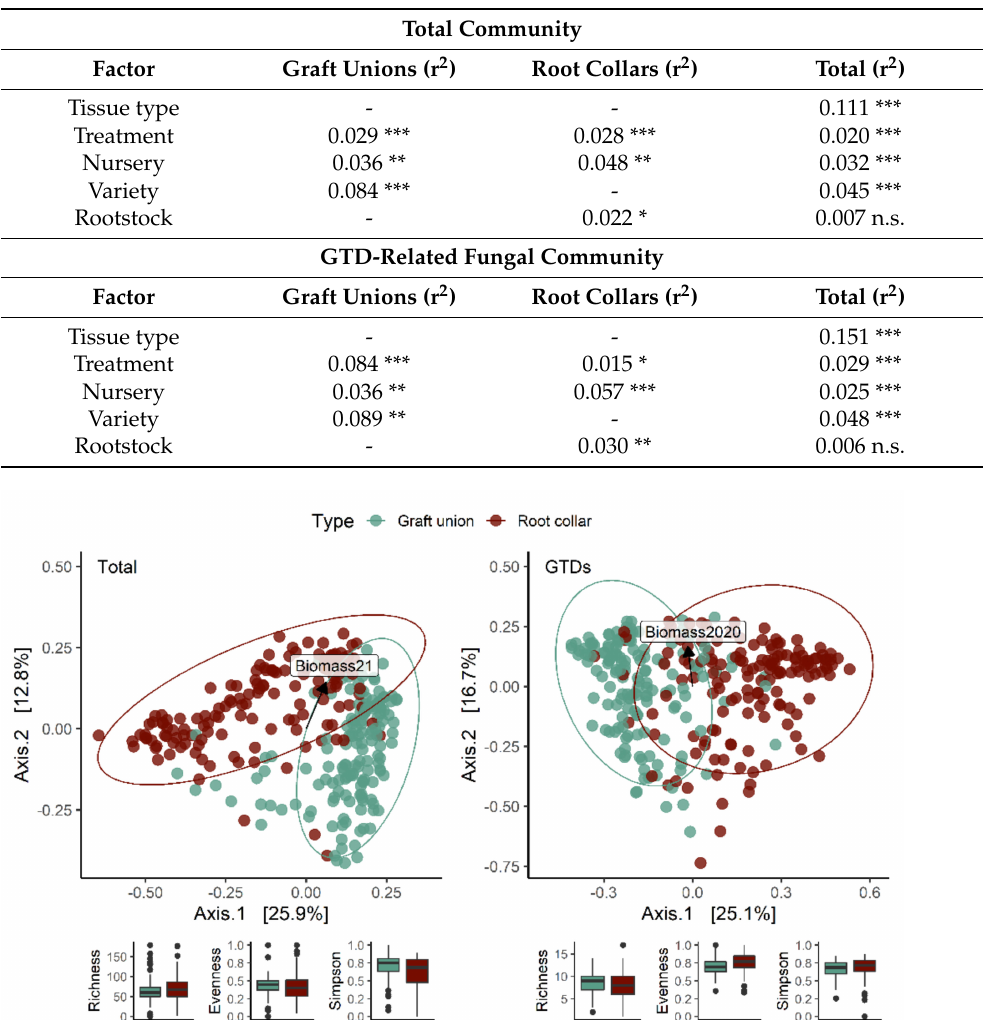
Table 3. Contribution of tissue type, treatment, nursery, and variety/rootstock to total community variation (top) and GTD community variation (bottom) in graft unions, root collars, and both tissues combined (total). The annotation following the value indicates the significance level: *** <0.001,